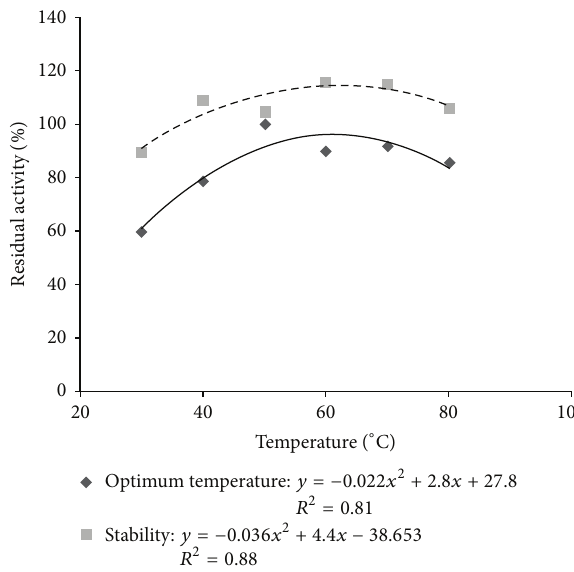
Figure 4: Effect of temperature and stability (2 hours incubation) on the tannase activity.